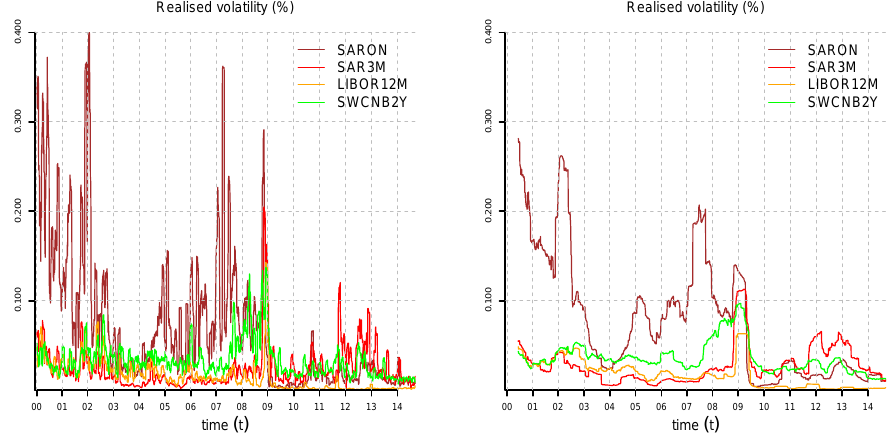
(cid:92) RCov ( t , τ , τ ) 1 2 for τ = 1, 63, 252,